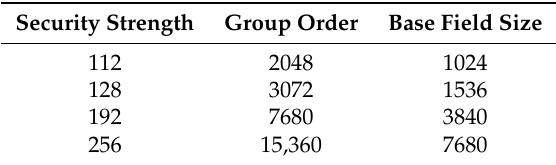
Table 2. Comparable cryptographic